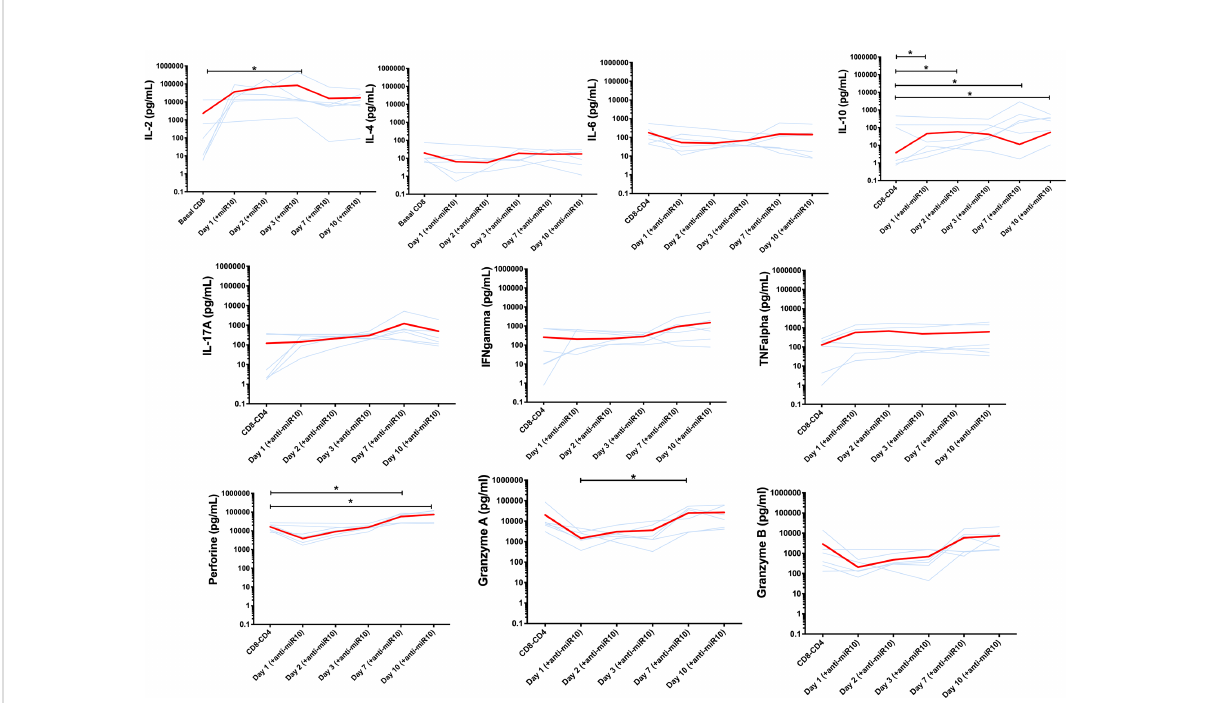
FIGURE 5 Cytokines secretion and cytotoxicity markers production before and after transfection of CD8 + T cells from progressors with miR-10a-5p inhibitor. Light blue lines represent individual trajectories and red lines the mean trajectories for IL-2, IL-4, IL-6, IL-10, IL-17A, IFNg, TNFa, perforin, granzyme A and B levels from three biological triplicates and two technical duplicates. Signi fi cant changes between time points were determined using a Wilcoxon sign-rank test.